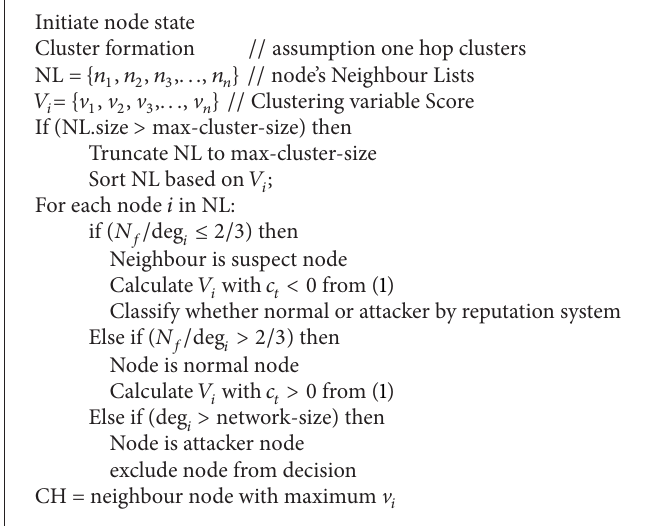
Algorithm 1: Secure cluster head selection algorithm.